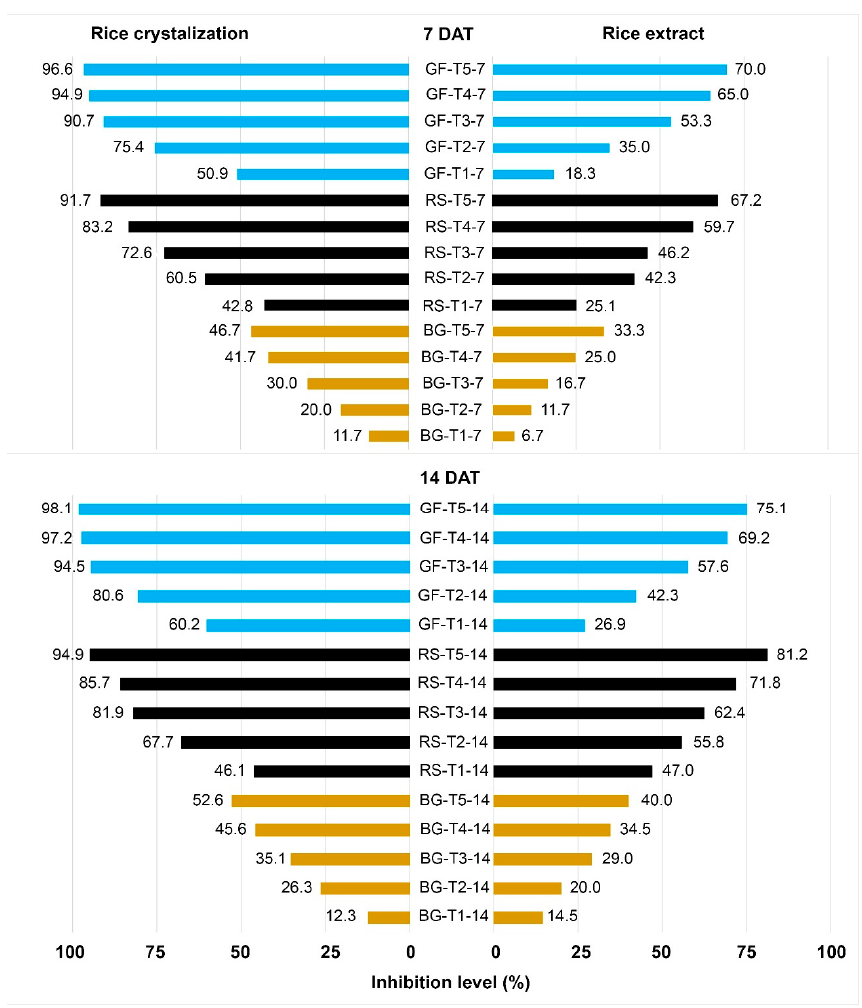
Figure 2. Comparative effect of OM 5930 crystallized by-product and OM 5930 rice extract (Inhibition level-% of the control) on grass-like fimbry - GF (blue columns), red sprandletop - RS (black columns), and banyardgrass - BG (orange columns) at 7 and 14 days after treatment (DAT). Rice crystallization treatments (g pot − 1 ) include T1: 9.4; T2: 14.13; T3: 18.84; T4: 23.55; and T5: 28.26. Rice extract treatments (g L − 1 ) include T1: 2.67; T2: 4.0; T3: 5.33; T4: 6.67; and T5: 8.0. The T1 through T5 treatments for both crystallized rice by-product and rice extract correspond with 1-, 2-, 3-, 4-, and 5-tons ha − 1 of mature rice biomass.